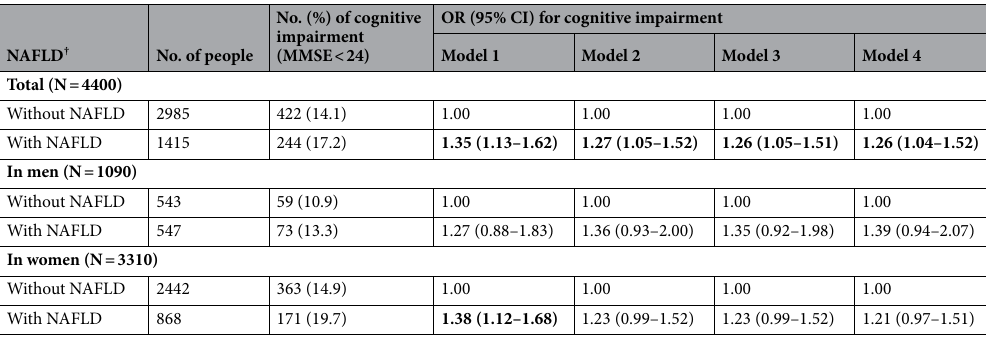
Table 2. Association between non-alcoholic fatty liver disease and cognitive impairment (MMSE < 24). Model 1: Sex, age. Model 2: Model 1 + education, household income, and marital status. Model 3: Model 2 + current drinker and current smoker. Model 4: Model 3 + diabetes and hypertension. † NAFLD was defined as FLI ≥ 30 0.953 × loge ( triglycerides ) + 0.139 × ( BMI ) + 0.718 × loge ( γ − GTP ) + 0.053 × ( waistcircumference ) − 15.745 (FLI = 100 × e 1 + e 0.953 × loge ( triglycerides ) + 0.139 × ( BMI ) + 0.718 × loge ( γ − GTP ) + 0.053 × ( waistcircumference ) − 15.745 ). NAFLD, non-alcoholic fatty liver disease; MMSE, Mini-Mental State Examination; OR, odds ratio; CI, confidence interval; FLI, fatty liver index; BMI, body mass index; γ-GTP, gamma-glutamyl transferase. Significant values are in